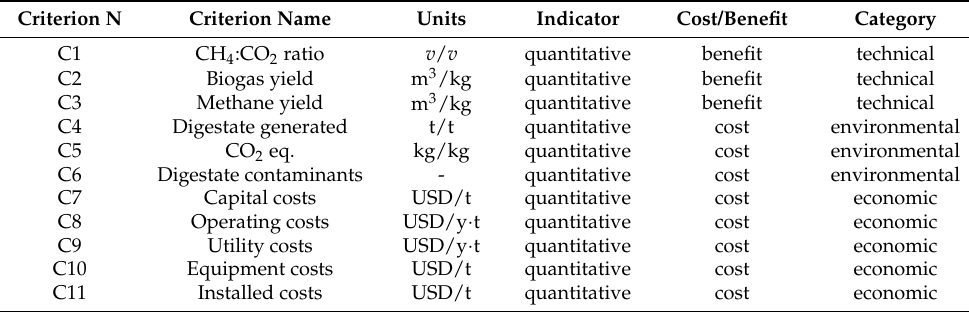
Table 1. Set of criteria considered in this case